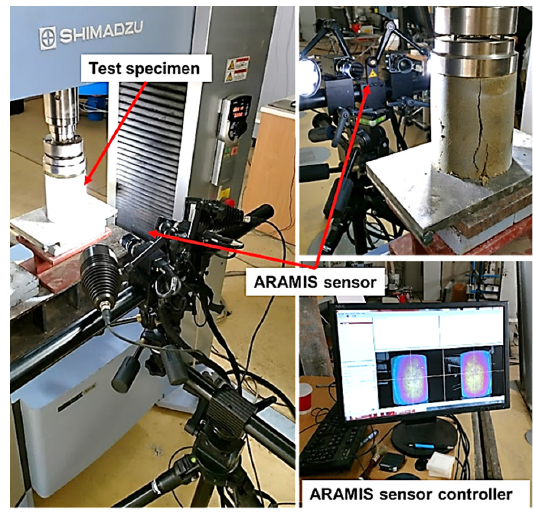
Figure 2. Test setup for 3D digital image correlation (DIC) measurements.